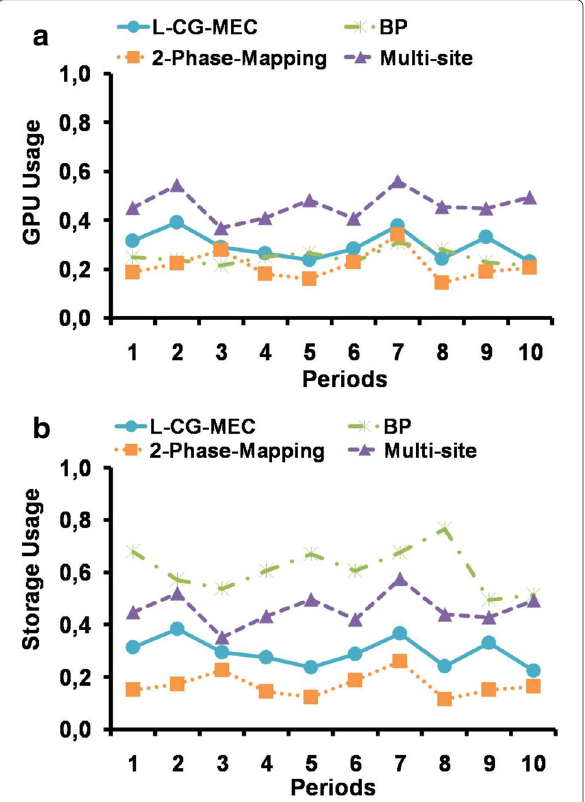
Fig. 6 Periodical MEC-DCs nodes resources usage. a GPU usage. b Storage